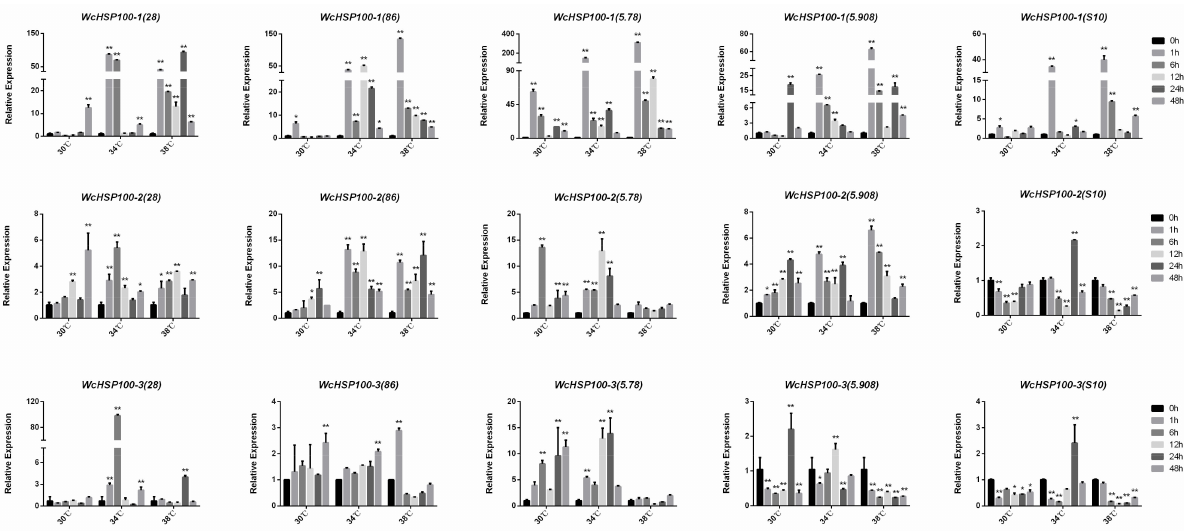
Figure 4. Analysis of expression patterns of WcHSP100 gene under different temperature treatments. The different strains ‘28’, ‘86’, ‘5.78’, ‘5.908’, and ‘S10’ of W. cocos are shown. All data are means ± SD of three technical replicates; the 0 h sample is taken as control, two-way ANOVA was employed to analyze the data, and significant differences are represented by asterisks: * p < 0.05; ** p <